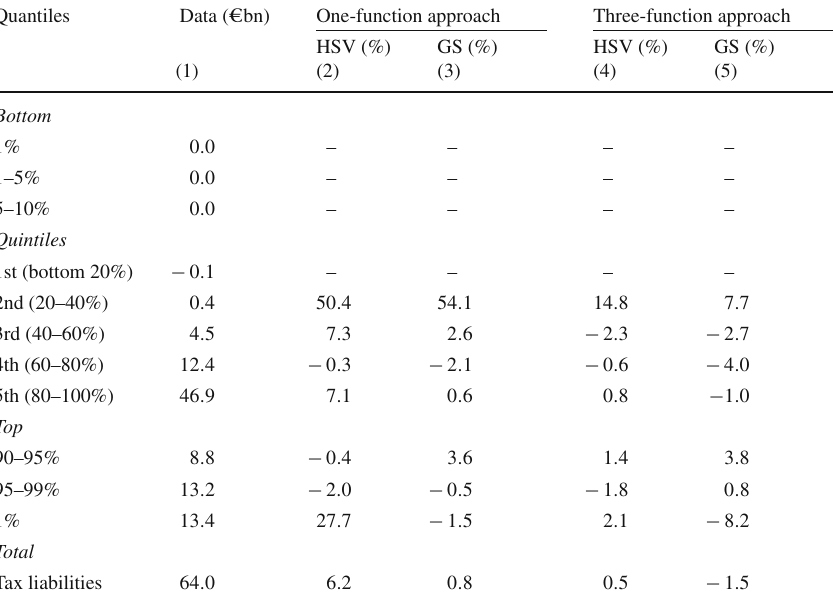
Table 12 Evaluation of tax functions: total tax liabilities in 2015 (% Difference with respect to the data) Quantiles Data ( e bn) One-function approach Three-function